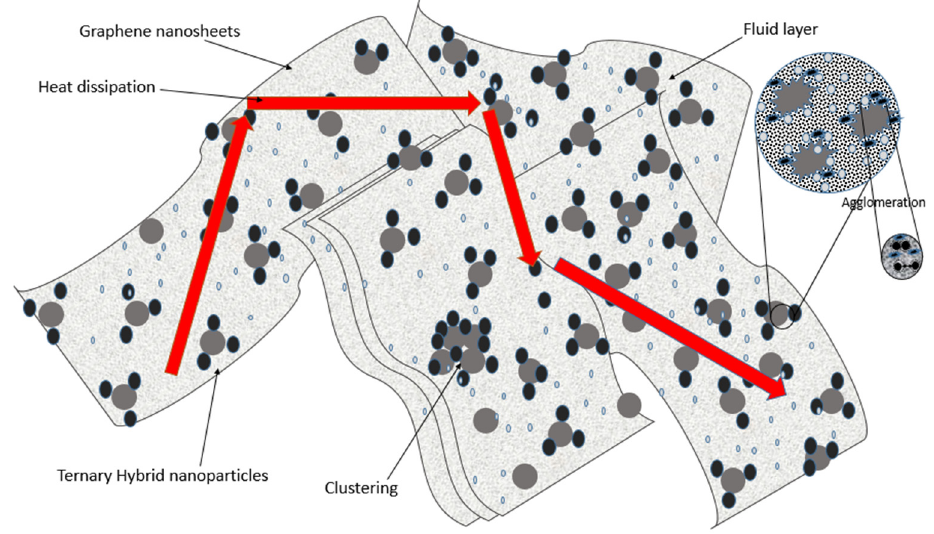
Figure 5. Schematic of the proposed thermal conductivity mechanism of THNp in the